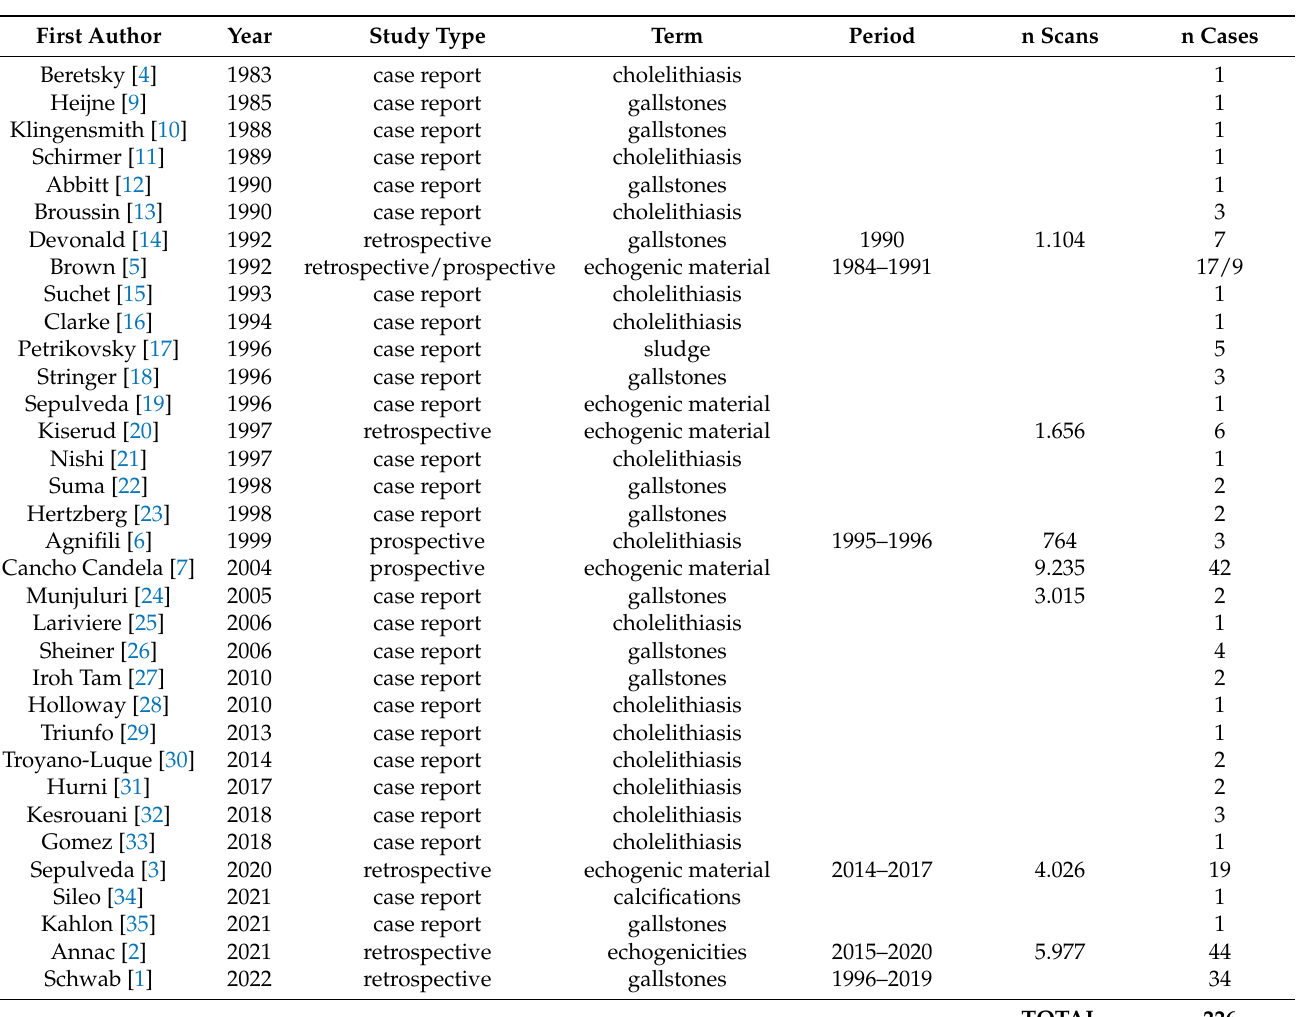
Table 1. Summary of the studies under review.